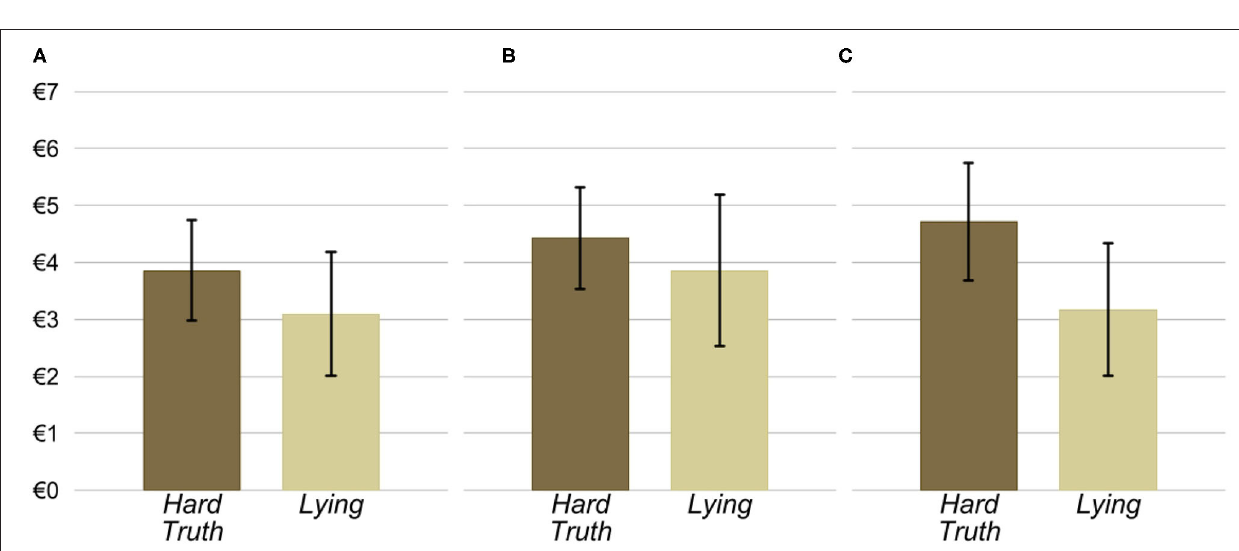
FIGURE 2 | Senders’ average antisocial cost and 95% confidence intervals depending on the condition and treatment. (A) Baseline. (B) Face to Face. (C) Face to Face &